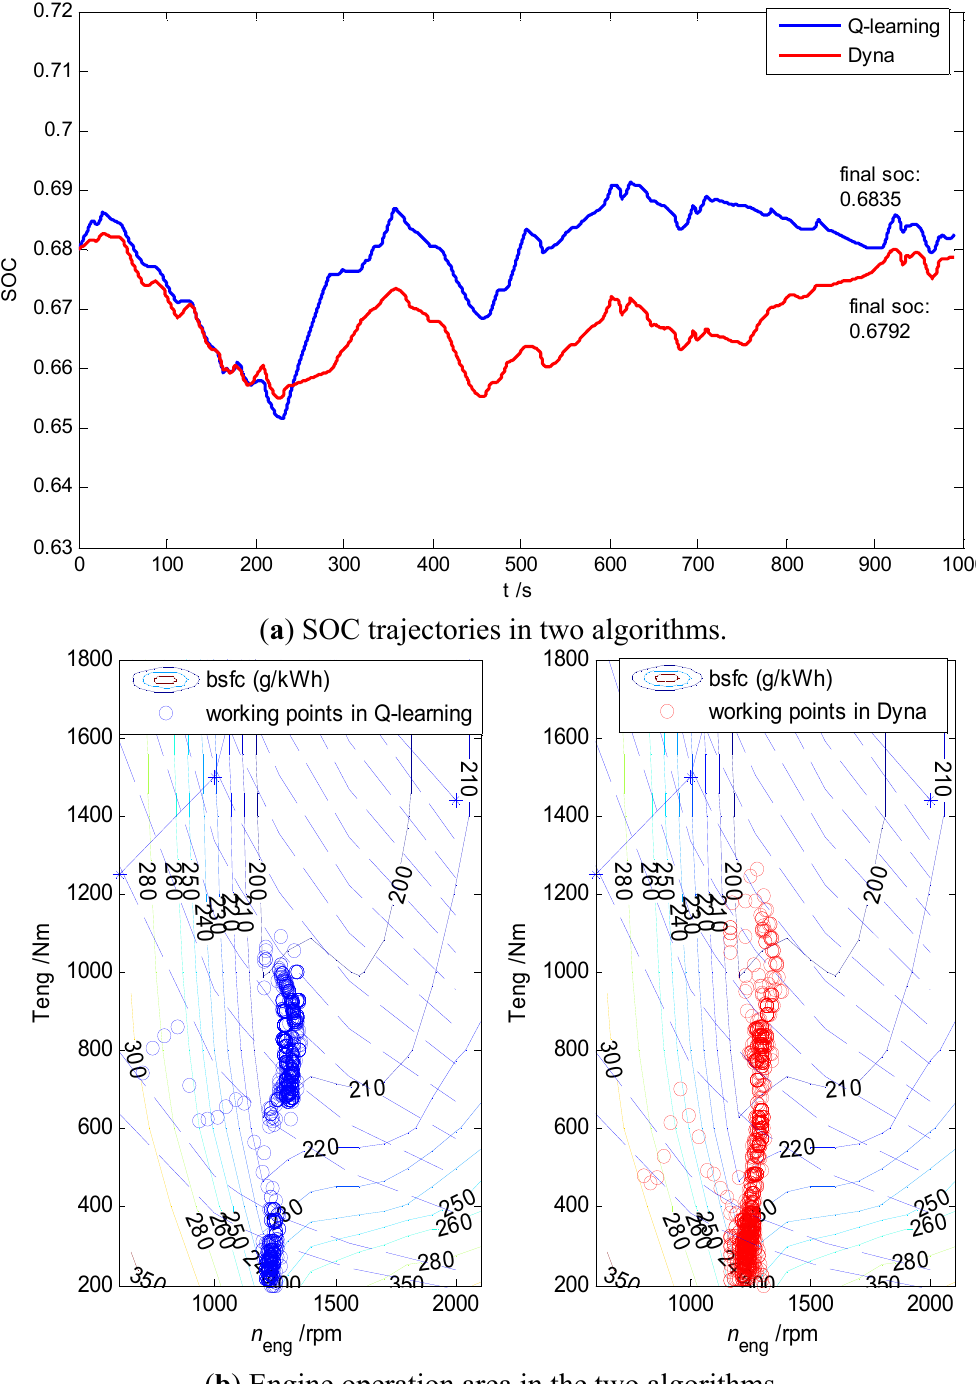
Figure 11. SOC trajectories and engine operation area in the Q -learning and Dyna